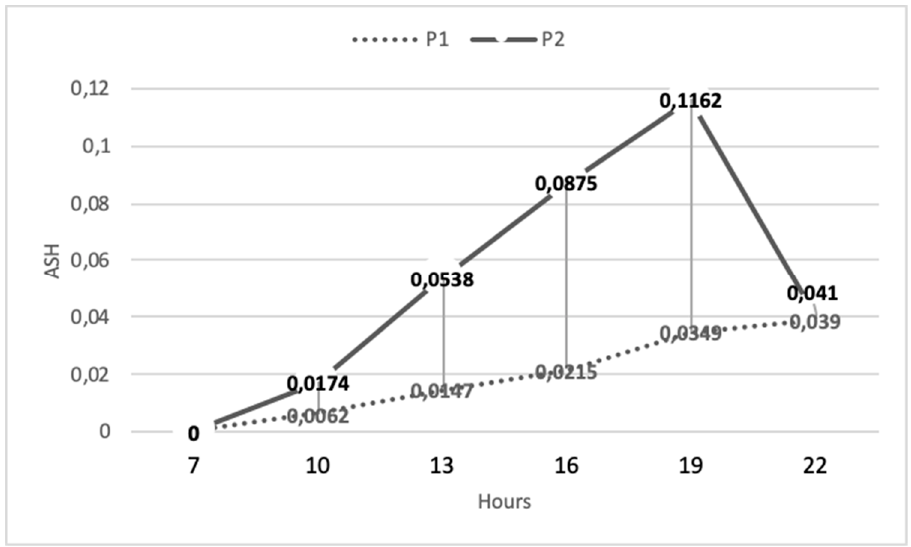
Figure 4. Mean values of the cumulative heat storage in P1 and P2.